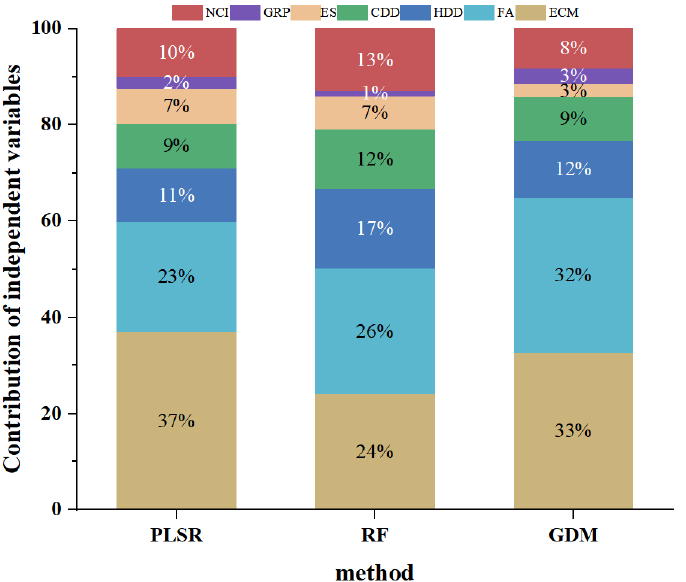
Figure 7. Contribution of independent variables to building energy consumption carbon emission obtained by PLSR, RF, GDM. (Note: NCI was the value of green space compactness. GRP represents Gross Domestic Product per person. ES represents education spending. CDD represents cooling degree days. HDD represents heating degree days. FA represents the building ’ s square foot area. ECM represents energy consumption membership. The unit of GRP and ES is yuan, the unit of CDD and HDD is °C·day, the unit of FA is hm 2 , the unit of ECM is person. PLSR represents partial least squares regression. RF represents random forests. GDM represents geographical detector model).